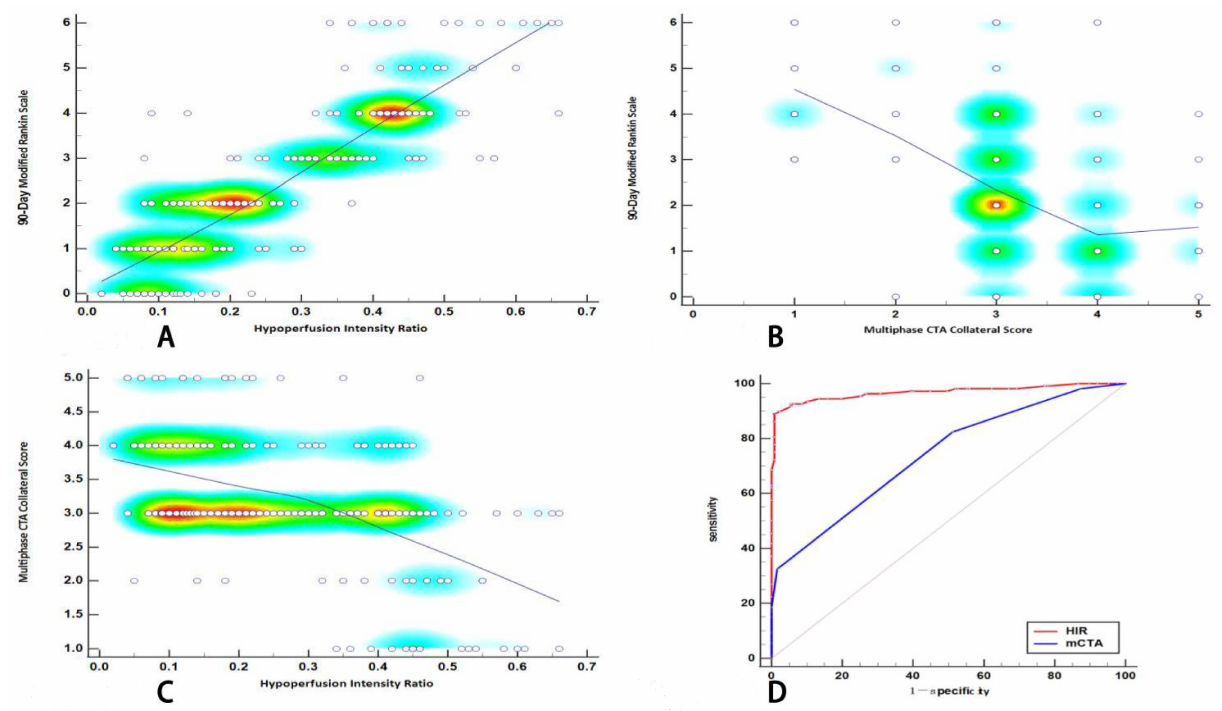
Figure 4. Correlations between HIR, mCTA collateral score and functional outcome, and the receiver operating characteristics. ( A ) Correlation between HIR and functional outcome. ( B ) Correlation between mCTA collateral score and functional outcome. ( C ) Correlation between HIR and mCTA collateral score. ( D ) ROC analysis in the prediction of an unfavorable functional outcome with HIR and mCTA collateral score. Abbreviations: HIR, hypoperfusion intensity ratio; mCTA, multi-phase CT angiography; ROC, Receiver operating characteristic. Table 2. Multivariable logistic regression analysis for functional outcome. Variables